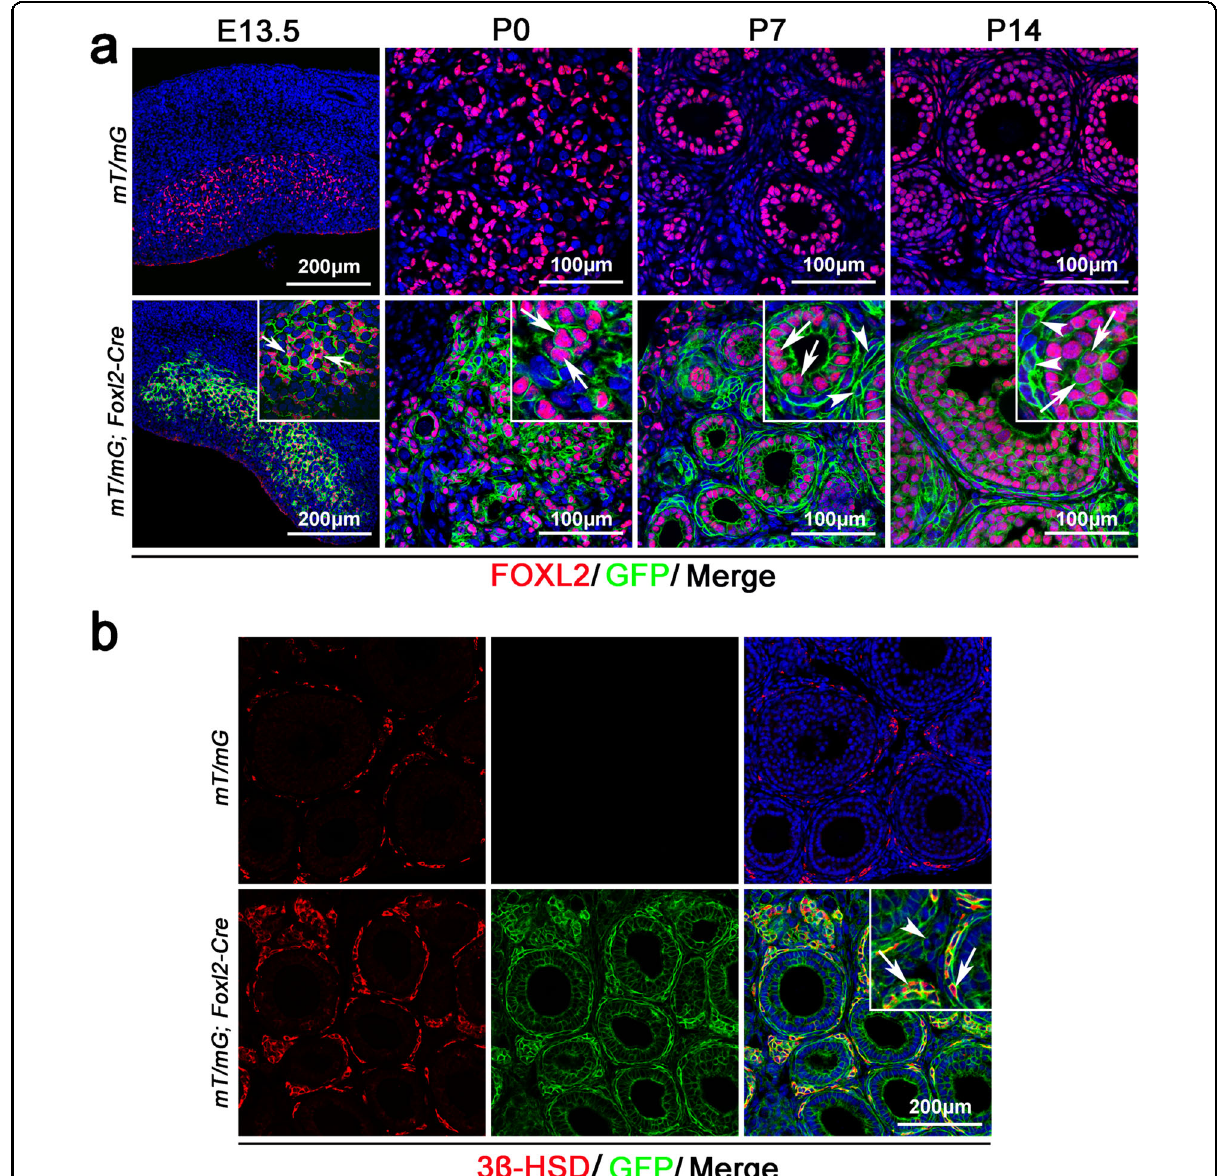
Fig. 1 Lineage tracing of Foxl2 -expressing cells in the fetal ovary with Foxl2 - Cre mice. a Foxl2 - Cre mice were crossed with mT/mG reporting mice and GFP signal was examined by immunostaining. GFP signal was not detected in the ovaries of mT/mG mice at E13.5, P0, P7, and P14 (top panel). GFP signal was detected in the ovaries of mT/mG; Foxl2-Cre mice at E13.5 (white arrows) and P0 (white arrows). GFP signal was not only detected in FOXL2-positive granulosa cells at P7 (white arrows) and P14 (white arrows) in mT/mG; Foxl2-Cre mice, but also in FOXL2-negative theca- interstitial cells (white arrowheads). b No GFP signal was detected in the ovaries of mT/mG mice at P14 (top panel). 3 β -HSD (red) and GFP double positive cells were observed in the ovaries of mT/mG; Foxl2-Cre mice at P14 (inset, white arrows). GFP-positive and 3 β -HSD-negative (inset, white arrowheads) stromal cells were also observed in mT/mG; Foxl2-Cre